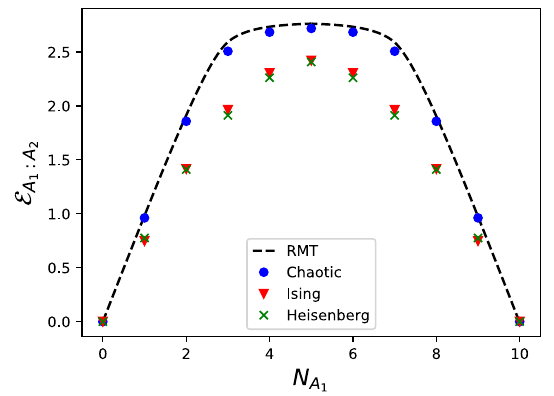
FIG. 9. Logarithmic negativity of two adjacent intervals of and N A in a highly excited state of a chaotic quantum length N A 1 2 + N = 10 and N = 4. spin-1 / 2 chain (blue circles). Here, N A A 2 B 1 For reference, we also show the corresponding plot for two inte- grable spin chains: Ising chain (red triangles) and Heisenberg chain (green crosses). See Appendix E for details of the numer- ics. The agreement between the random matrix theory (dashed line) and chaotic spin chain is evident. To calculate LN from ran- dom matrix theory (RMT), we numerically take the imaginary part of the solution to the cubic Eq. (101) and then calculate the negativity via Eq.